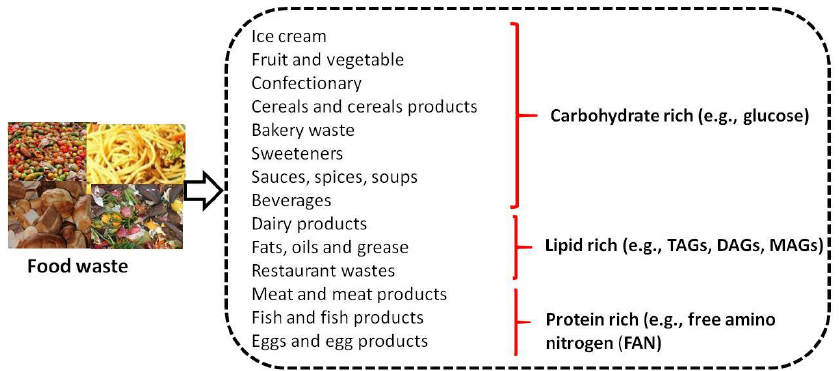
Figure 4. The compositional diversity of food